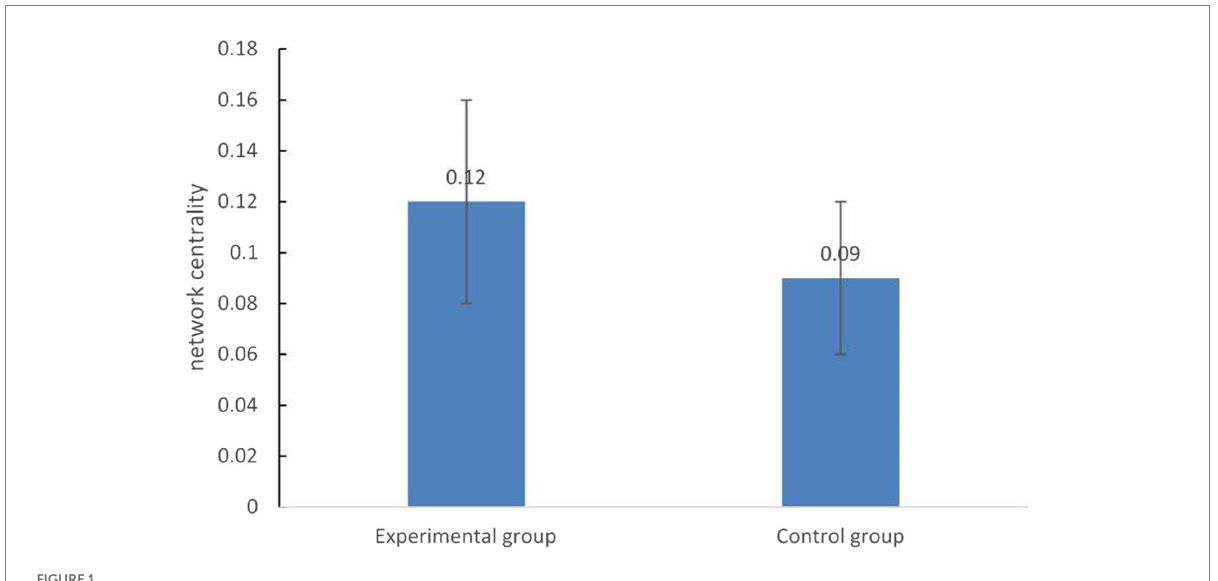
FIGURE 1 Comparison of the network centrality between the two